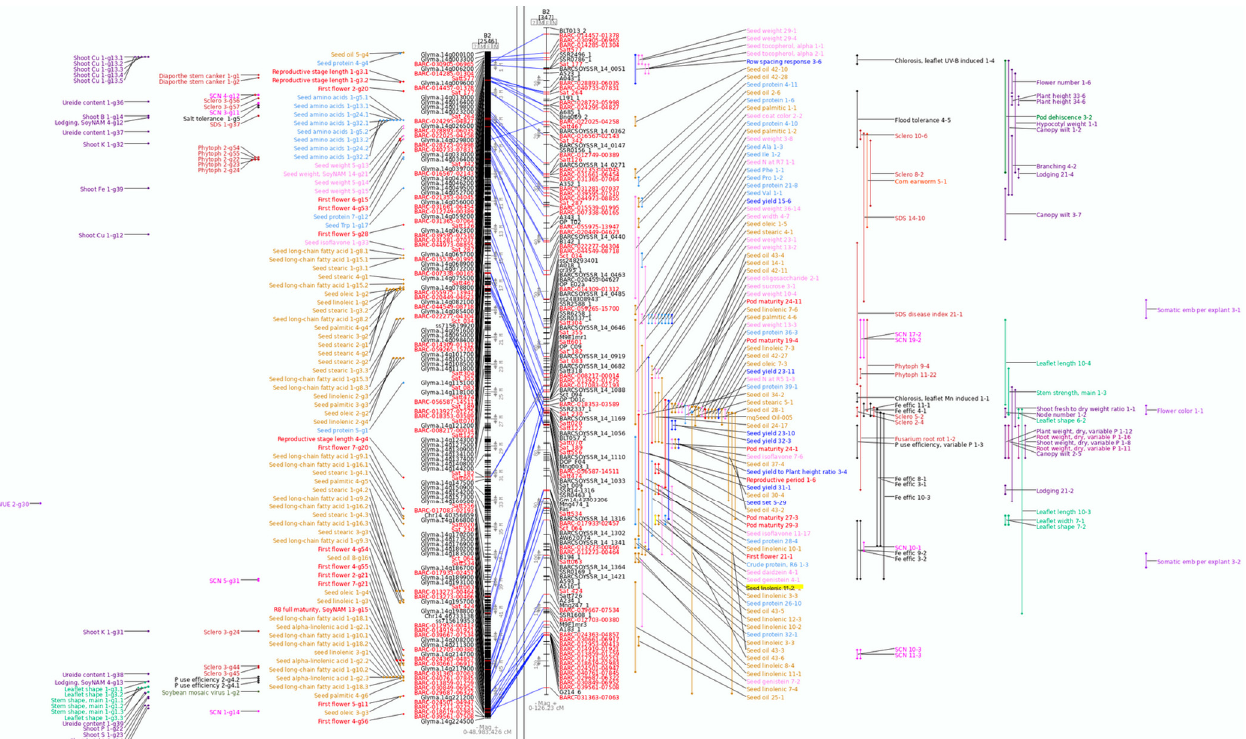
Figure 1. The composite genetic map and physical map of linkage group B2/chromosome 14. The left pane shows the physical or sequence map based on the soybean reference cultivar Williams 82. Genetically mapped molecular markers for which the sequence is available are shown on the physical map along with the gene models. The right pane shows the GmComposite2003 genetic map. This map was created in 2003 as the composite genetic map for soybean and is continually updated with new QTL and genetic markers. Markers in common between the two maps are connected by blue lines and shown in red text. Both bi-parental and GWAS QTL are grouped in columns by function or developmental category. Related QTL within categories are shown using the same color. Both QTL types use the same groupings and color to make correlations across the chromosome representations easier. The Seed linolenic 11-2 QTL is highlighted in yellow. Larger version.